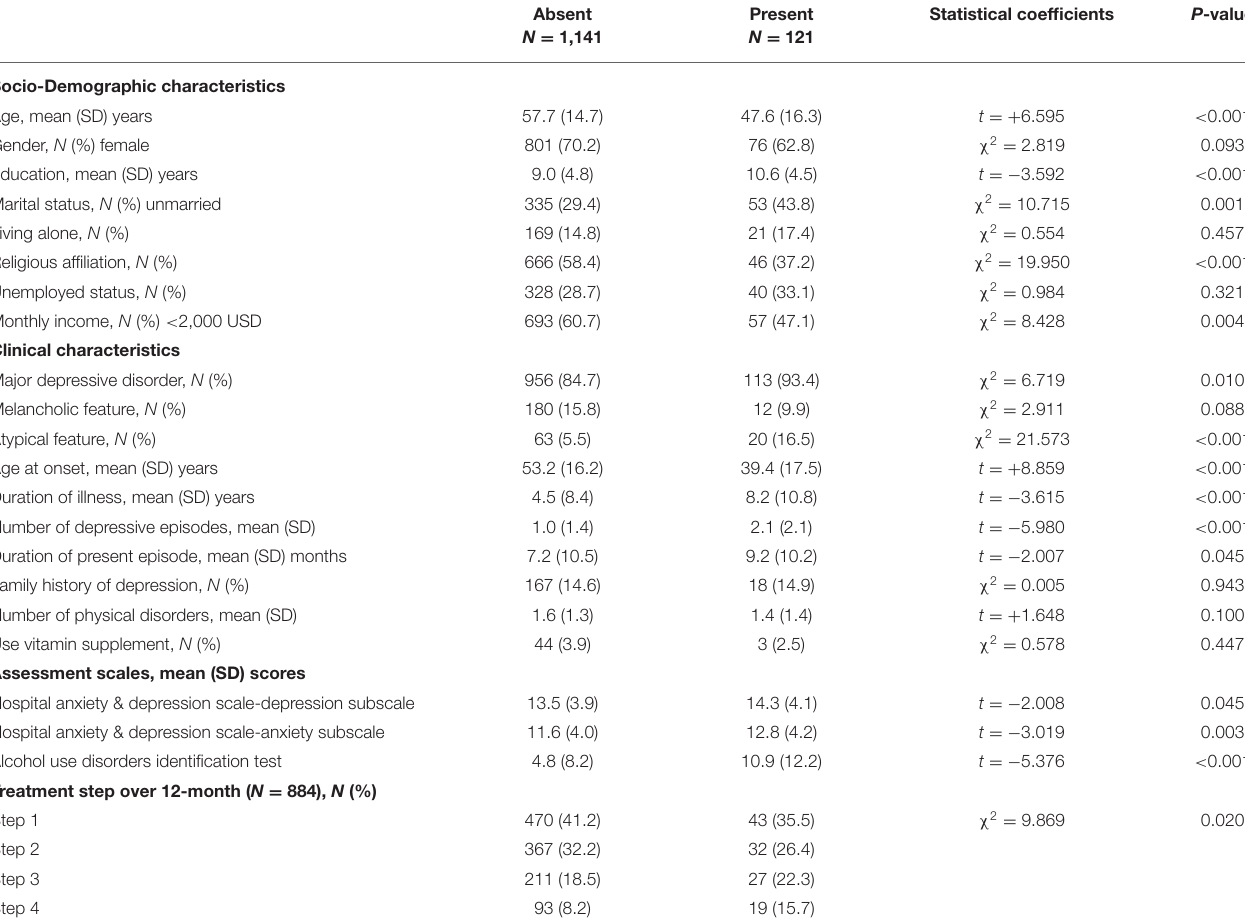
TABLE 2 | Characteristics compared by previous suicidal attempt before the study enrolment.